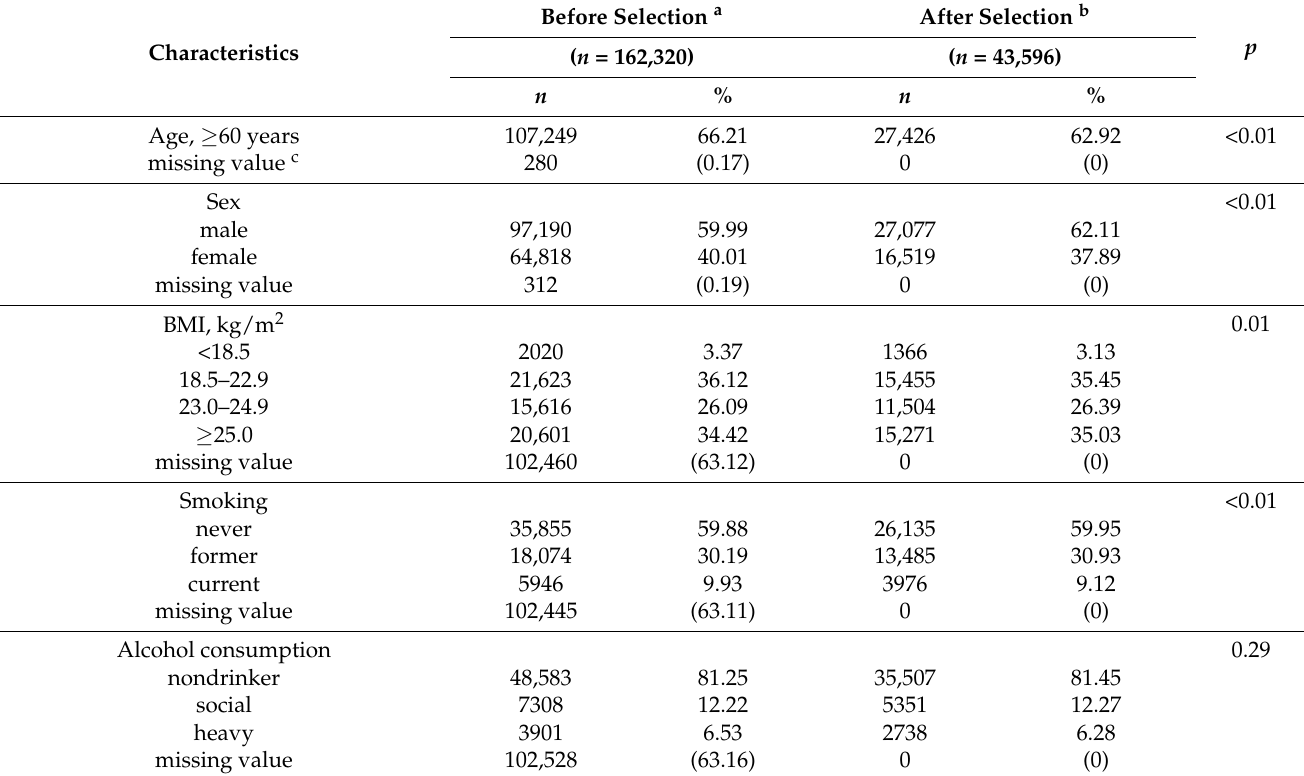
Figure 1. Flow chart to selecting study subjects from the Korean National Health Insurance Service Database. ICD-10 indicates International Classification of Diseases, Tenth Revision. Table 1. Comparison of the demographic and the clinical characteristics of colorectal cancer patients before and after selection, 2009–2016.